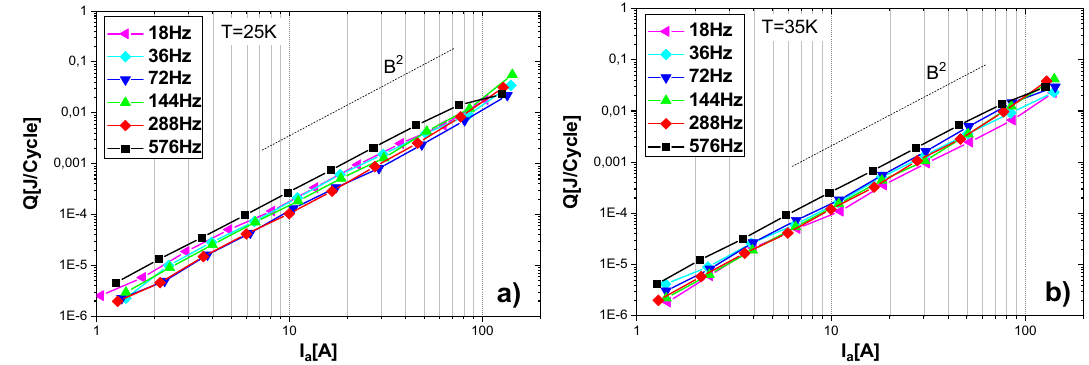
Figure 4. Coil AC loss per unit cycle versus transport current amplitude at temperatures 25 K and 35 K.